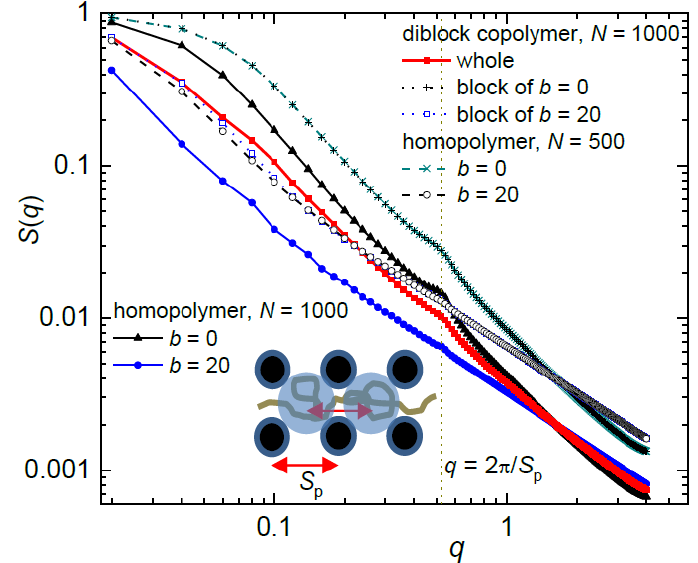
Figure 9. Structure factor of a diblock chain, its blocks and homopolymer chains corresponding to the blocks as well as a flexible and semi-flexible homopolymer of the same length as a copolymer at the moderate confinement of a post array with d p = 6.9, S p = 12. The dashed line indicates the q value corresponding to the distance between the axes of the adjacent interstitial volumes, S p , outlined in the inset.